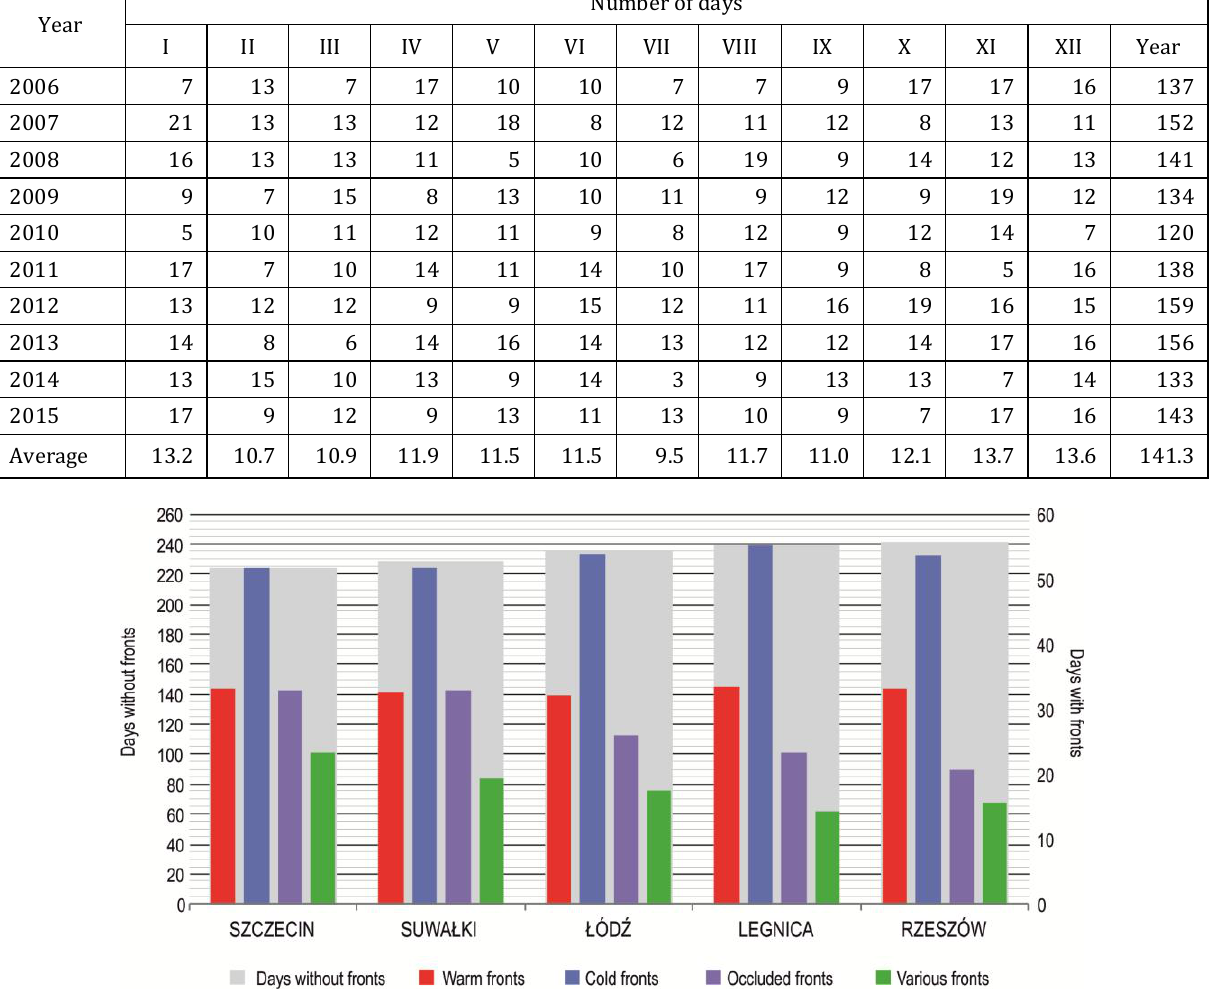
Fig. 2. Average annual number of days with particular types of atmospheric fronts at selected stations in the period